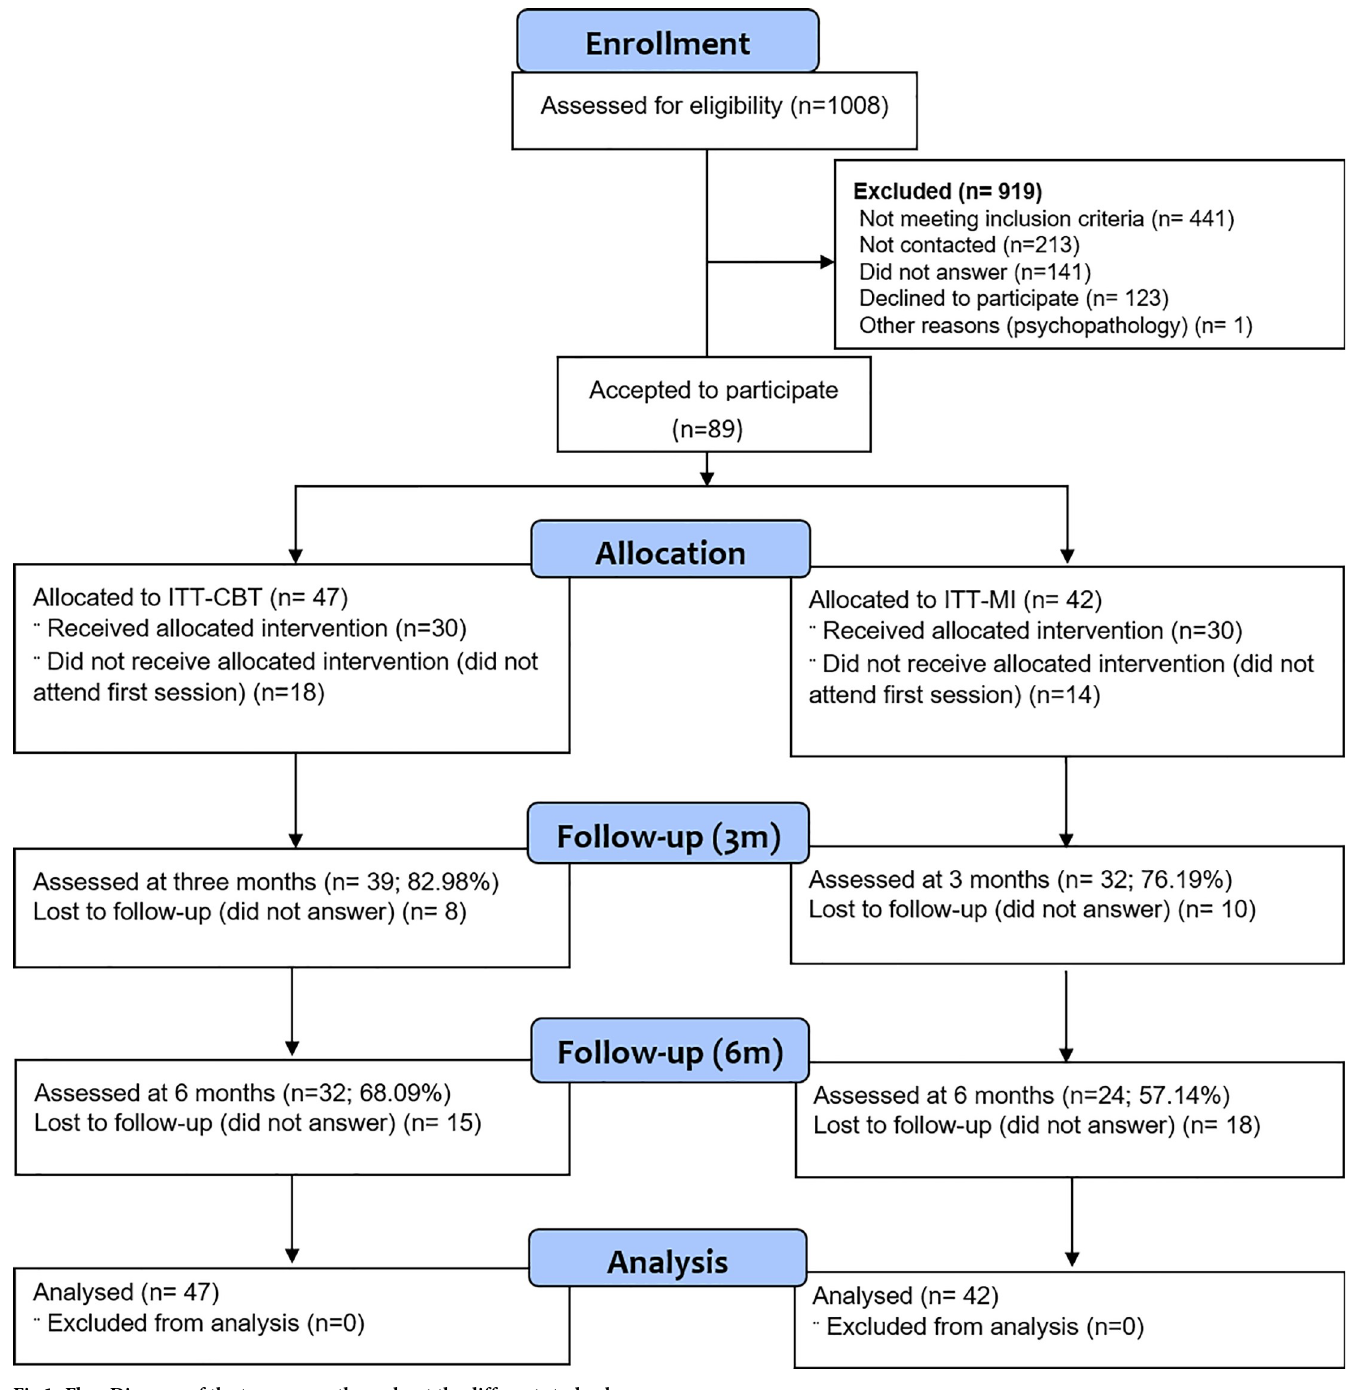
Fig 1. Flow Diagram of the two groups throughout the different study